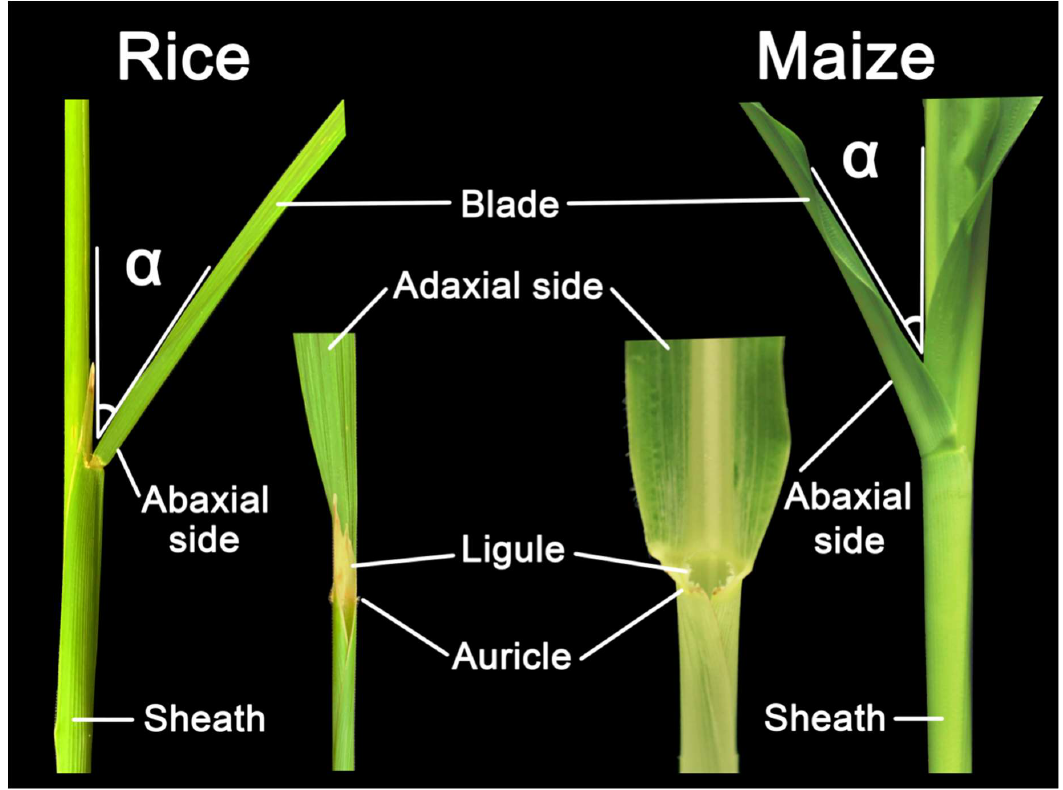
Figure 1. Structural composition of leaf angle in rice and maize. Leaf angle is defined by the angle between the plant stem and leaf adaxial side of the blade, indicating as the α in the figure. This leaf morphology is affected by the development of ligule and auricle as well.